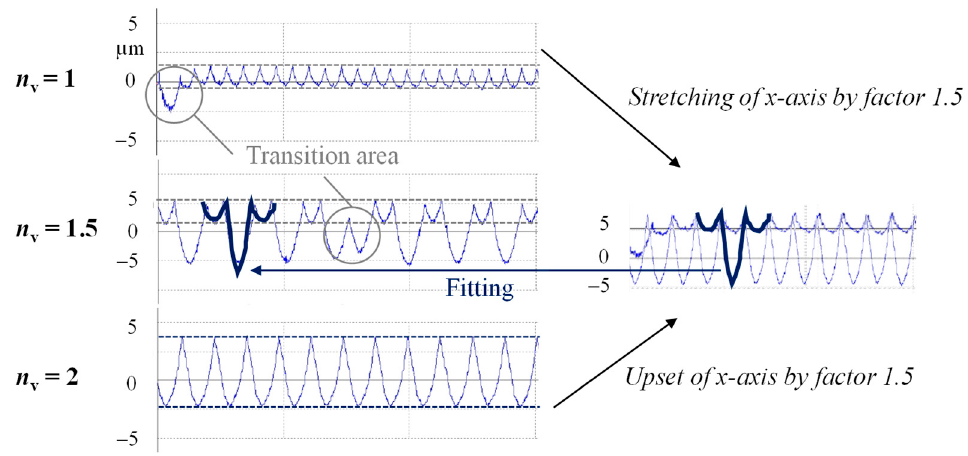
Figure 6. Roughness profiles with dwell values of n v = 1/1.5/2 for hardened steel.